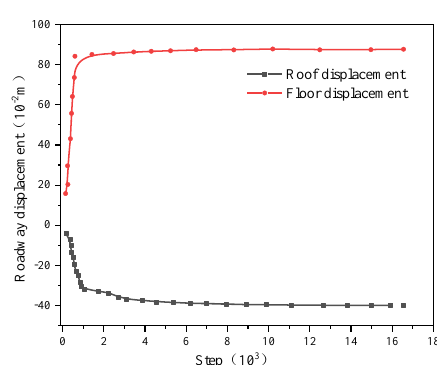
Figure 15. Vertical stress distribution of surrounding rock of roadway supported by bolt and shed. ( a ) Working face is 60 m away from the roadway. ( b ) Working face is 20 m away from the roadway. ( c ) Working face spans the roadway 20 m. ( d ) Working face spans the roadway 60 m.